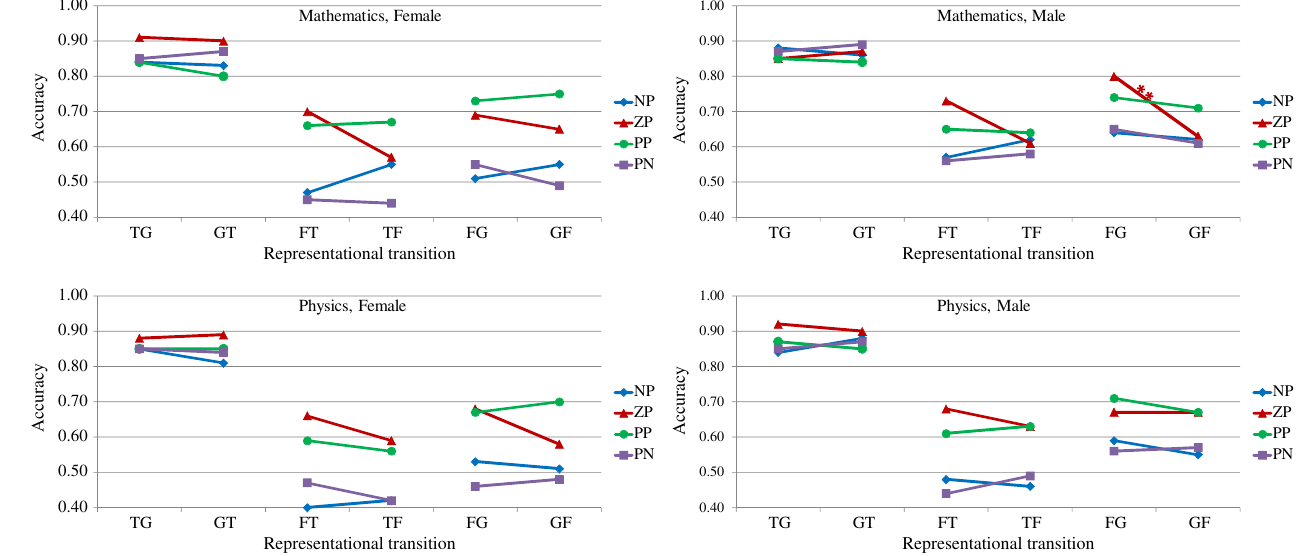
FIG. 8. Data from the 4-way interaction effect of representational transition, function type, context and gender. (a) Mathematics*Fe- male; (b) Mathematics*Male; (c) Physics*Female; (d) Physics*Male. The p value of the comparisons is indicated by * for p < 0 . 05 , ** for p < 0 . 01 , *** for p < 0 . 001 . The only significant asymmetry is for the ZP function type between FG and GF transitions in the mathematics context with